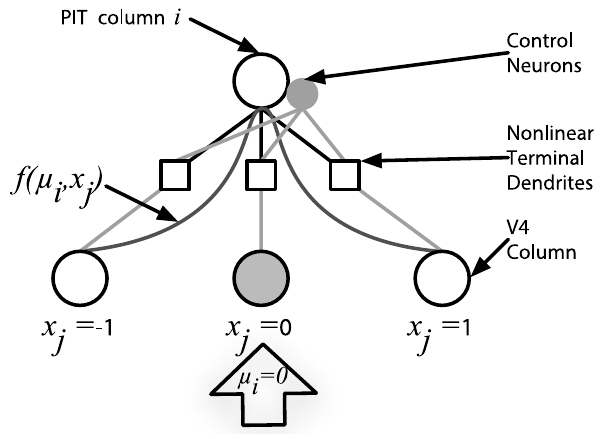
Figure 3. Selective routing for a single PIT column. The Gaussian routing function f ( m i , x j ) is centred on input column x j ~ 0 ( m i ~ 0) , and control neurons in the PIT column project the local control signal to the dendritic subunits of layer-IV neurons in that column. The gain of visual signals from each column is scaled by the corresponding value produced by the routing